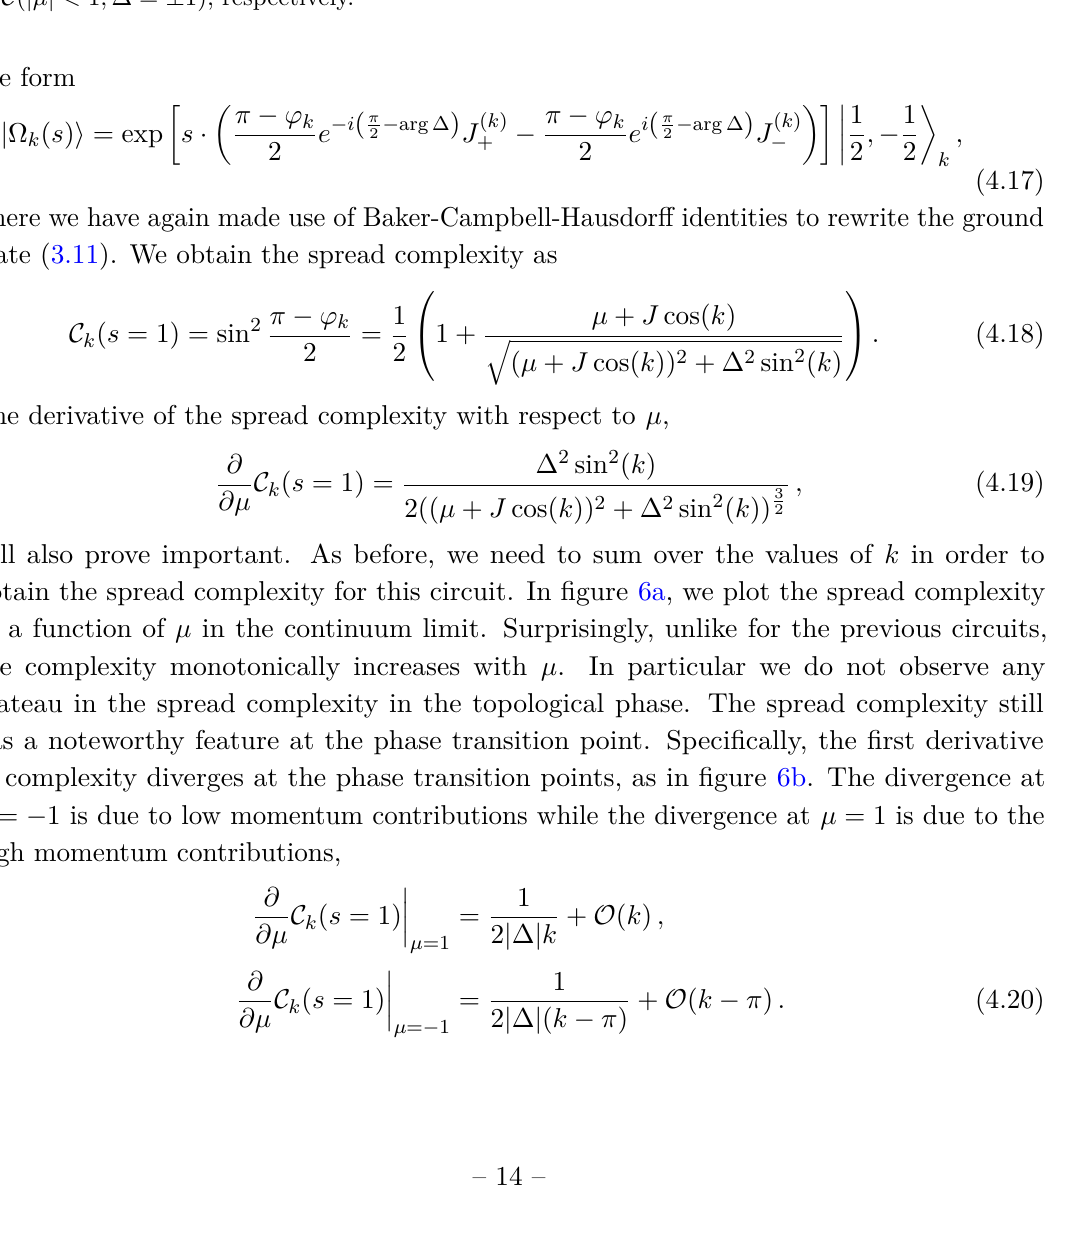
Figure 5 . Complexity C ( s = 1; | µ | < 1 , ∆) as a function of ∆ for the circuit connecting the Cooper-pair ground state and Kitaev chain ground state. The two red dots are the analytical results of C ( | µ | < 1 , ∆ = ± 1) ,